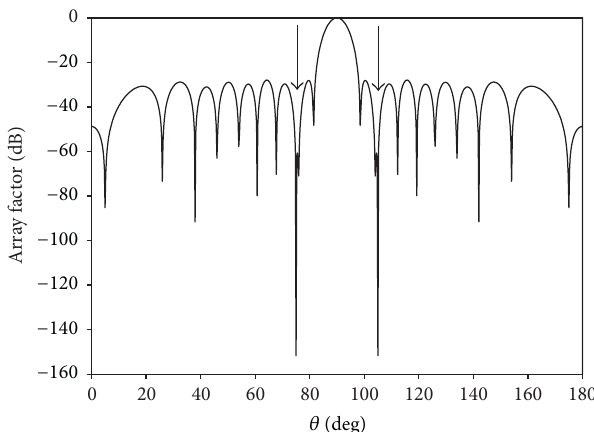
FNBW (deg.) Figure 6: Radiation pattern obtained by position-only control with one imposed null at 105 ∘ .